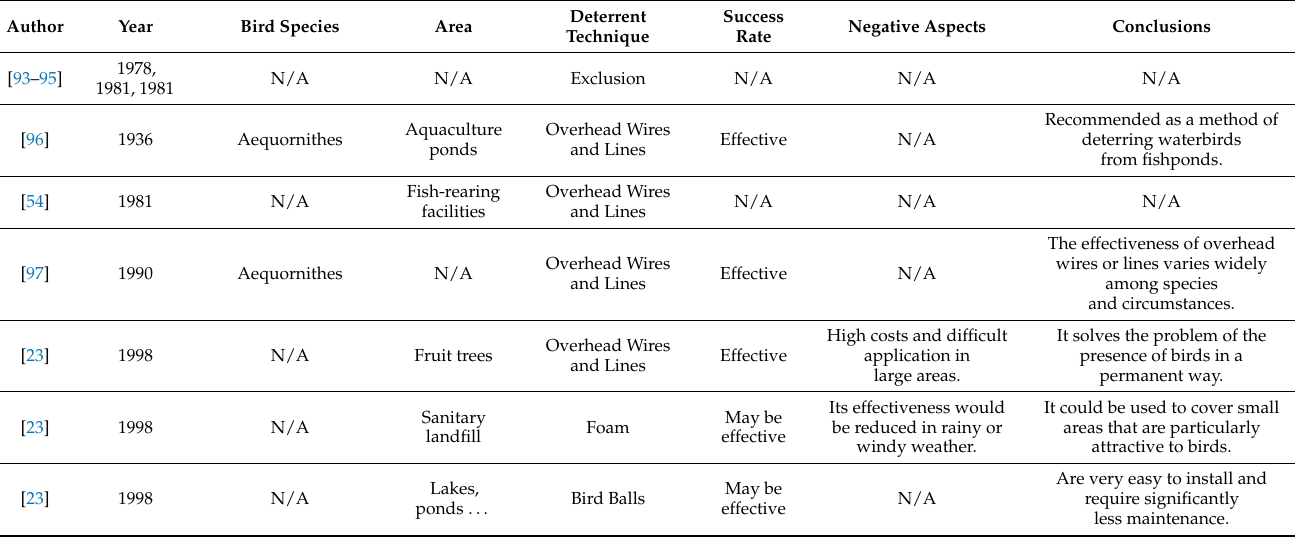
Table 4. Summary of the studies using exclusion